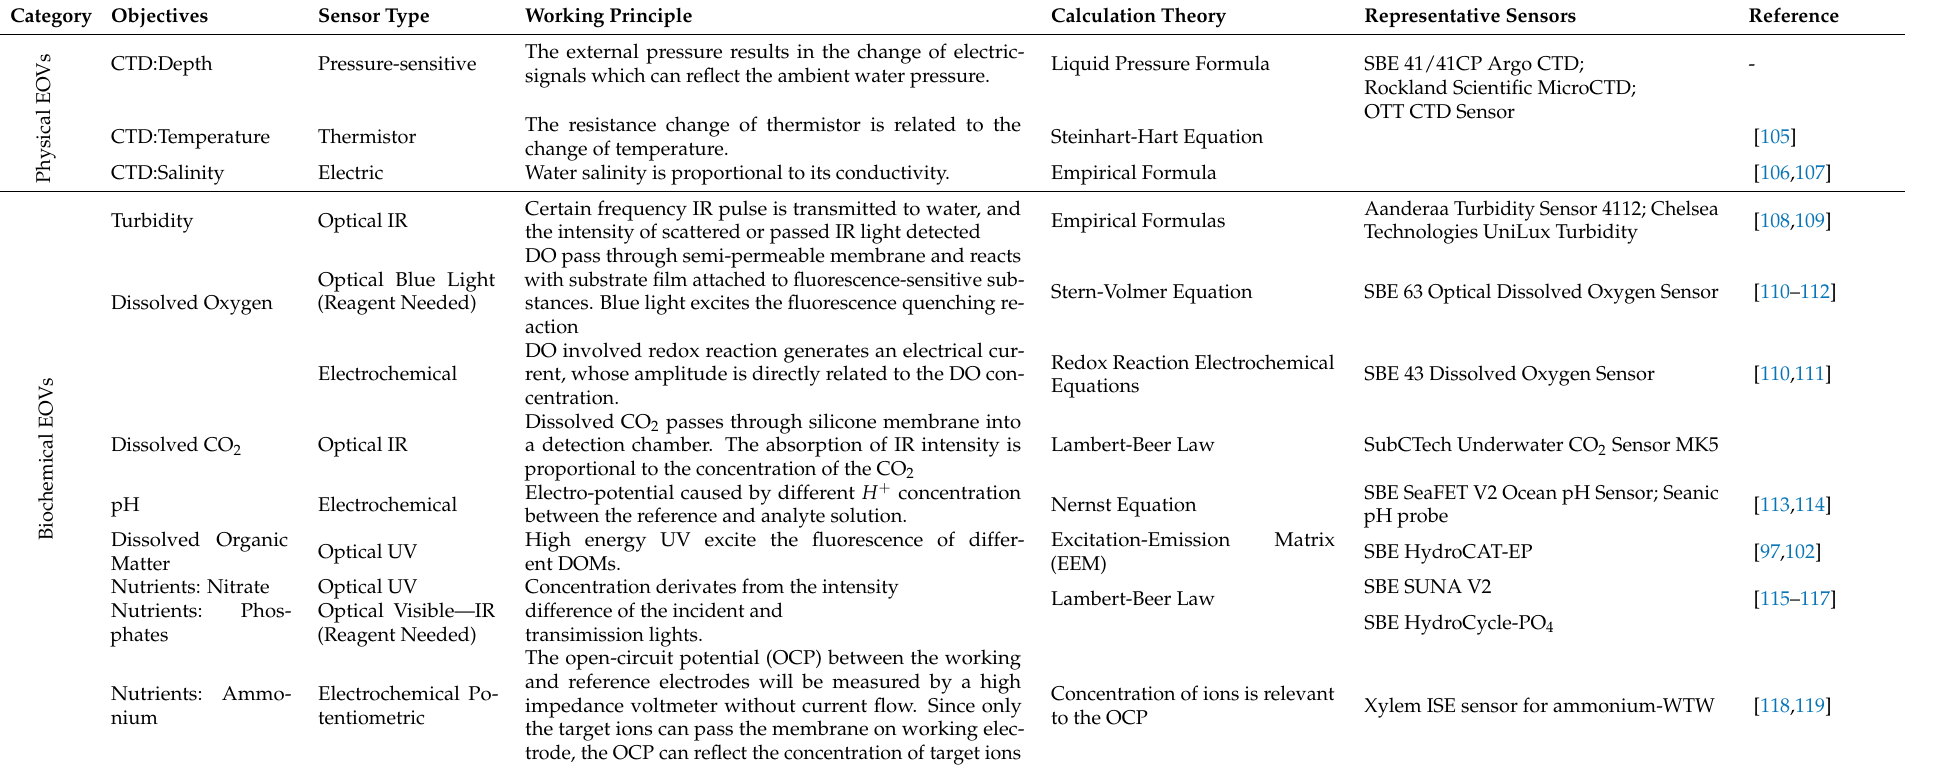
Table 4. Commercially used marine environmental parameters and their